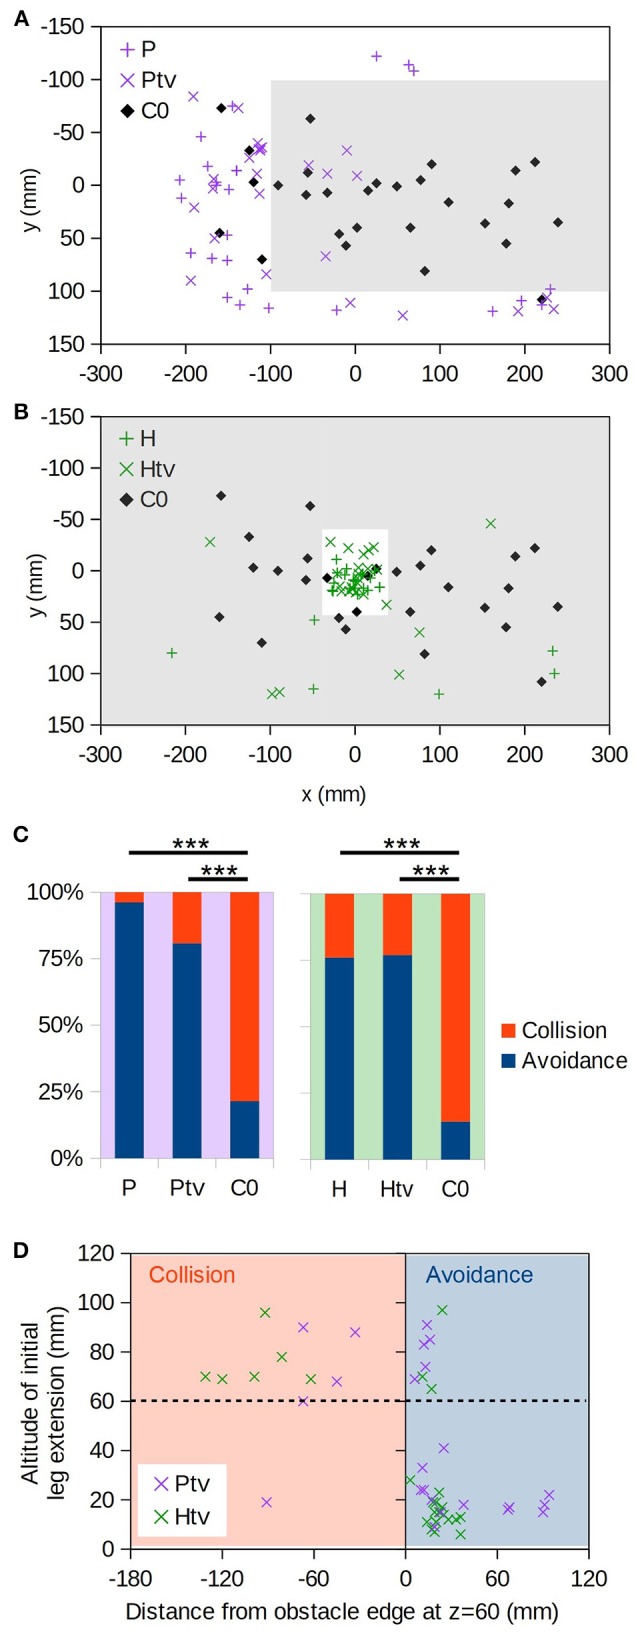
Virtual object avoidance. (A) (x,y) positions at which individuals initially descended through the plane of the virtual platform (i.e., z = 60 mm); the extent of the virtual platform is indicated by gray shading. Thus, descents occurring within the shaded area correspond to “collisions” with the virtual obstacle. Coloured “+” symbols are for the realistic occlusion condition (P), and “×” symbols for the condition where the target is always visible (Ptv). Black diamonds are the control condition, where no obstacle exists (C0). (B) As A, but for the hole obstacle. (C) Proportions of descents resulting in collision vs. avoidance. For C0 no virtual obstacle is present, but we assess whether each descent would have collided with the obstacle in question, thereby providing an estimate of the avoidance rate due to chance alone. “***” denotes p < 0.001 (Fisher's exact test); numbers of individuals are as follows: nP = 26, nPtv = 26, nH = 25, nHtv = 26, nC0 = 28. (D) Altitude of initial leg extension as a function of distance from the edge of the virtual obstacle. Negative distances correspond to collisions (orange shading). Dashed line is the virtual obstacle plane.